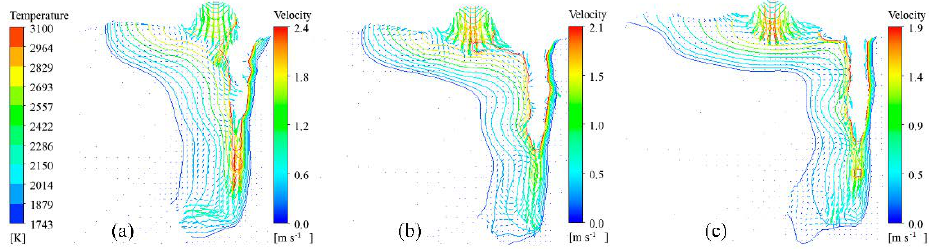
Figure 4. Morphology and flow rate of molten pool with different laser − arc spacing: ( a ) 1 mm, ( b ) 2 mm, ( c ) 3 mm.